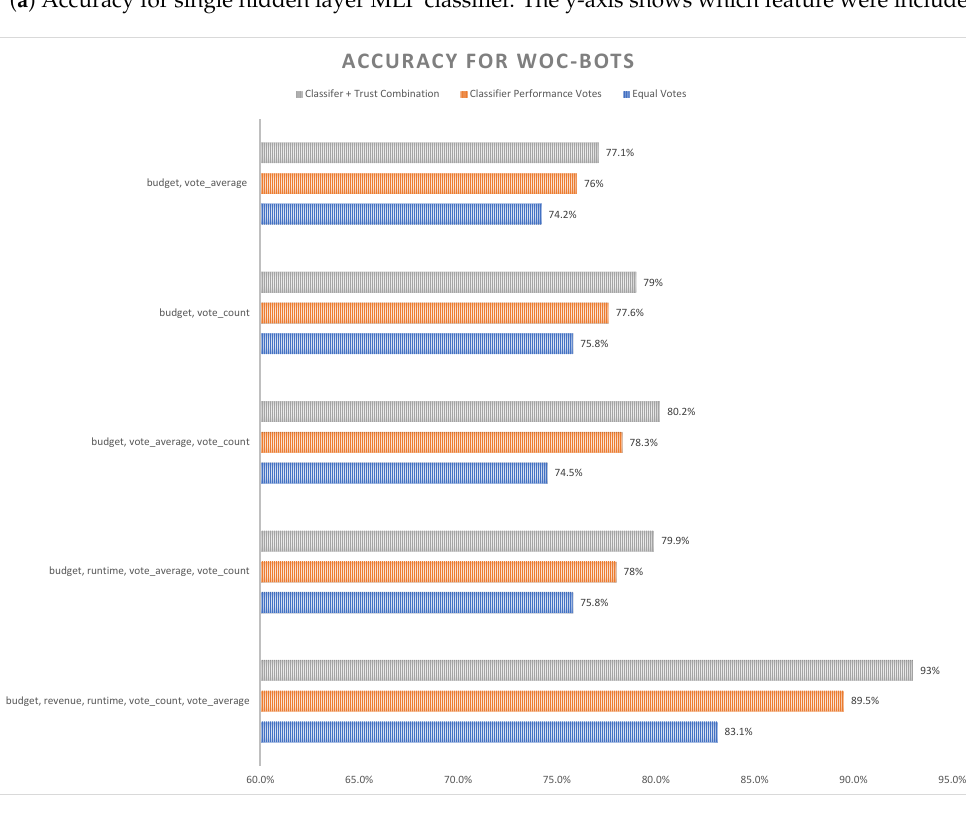
Figure 2. Comparison of MLP and Woc-Bots